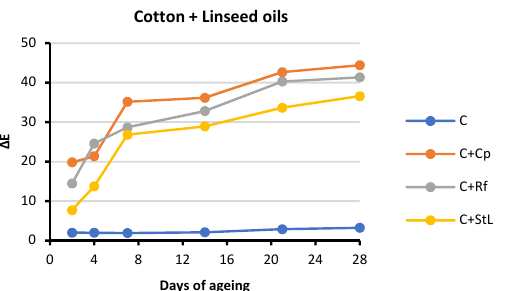
Figure 3. Graph representing colour changes ( ΔΕ *) of all sets of mock-ups upon ageing.